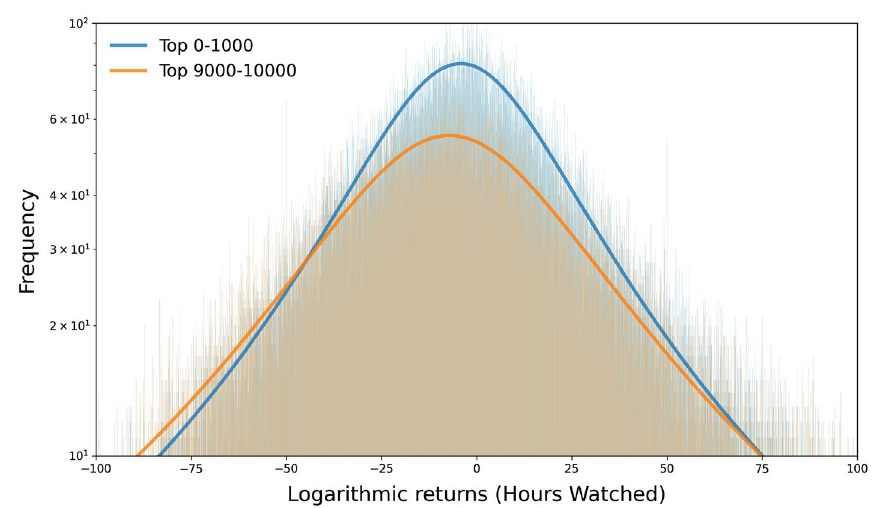
Figure 5. Histogram of the hours watched logarithmic returns (weekly). Histogram of the Logarithmic returns of the hours watched and the fitted Cauchy curve for the Top 0–1000 (Location ≈ 3.15, Scale ≈ 29.4) and Top 9000–10,000 streamers (Location ≈ − 7.88, Scale ≈ 39.61). These fits show that top streamers manage to keep a more stable viewership through time whereas the low end of the distribution has a more volatile